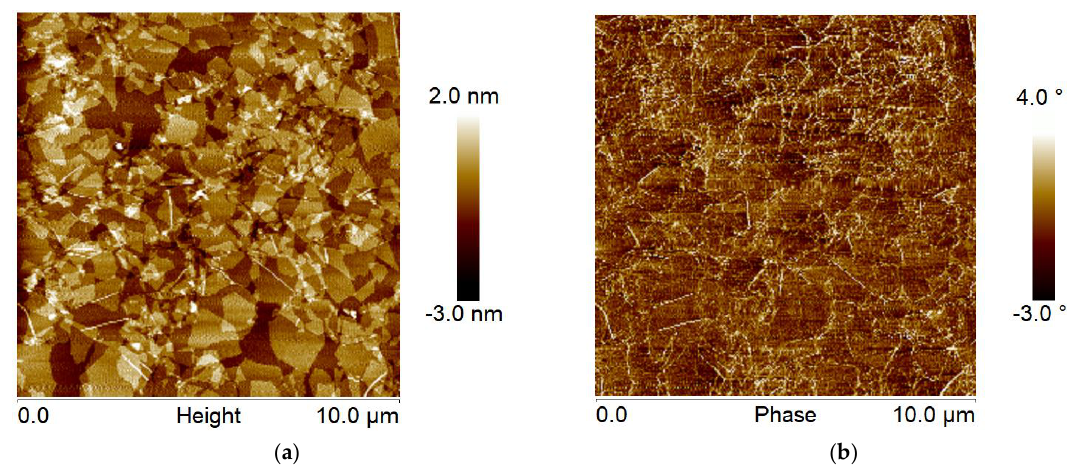
Figure 4. AFM topographical ( a ) and phase ( b ) images of a GO layer on a SiO 2 surface.